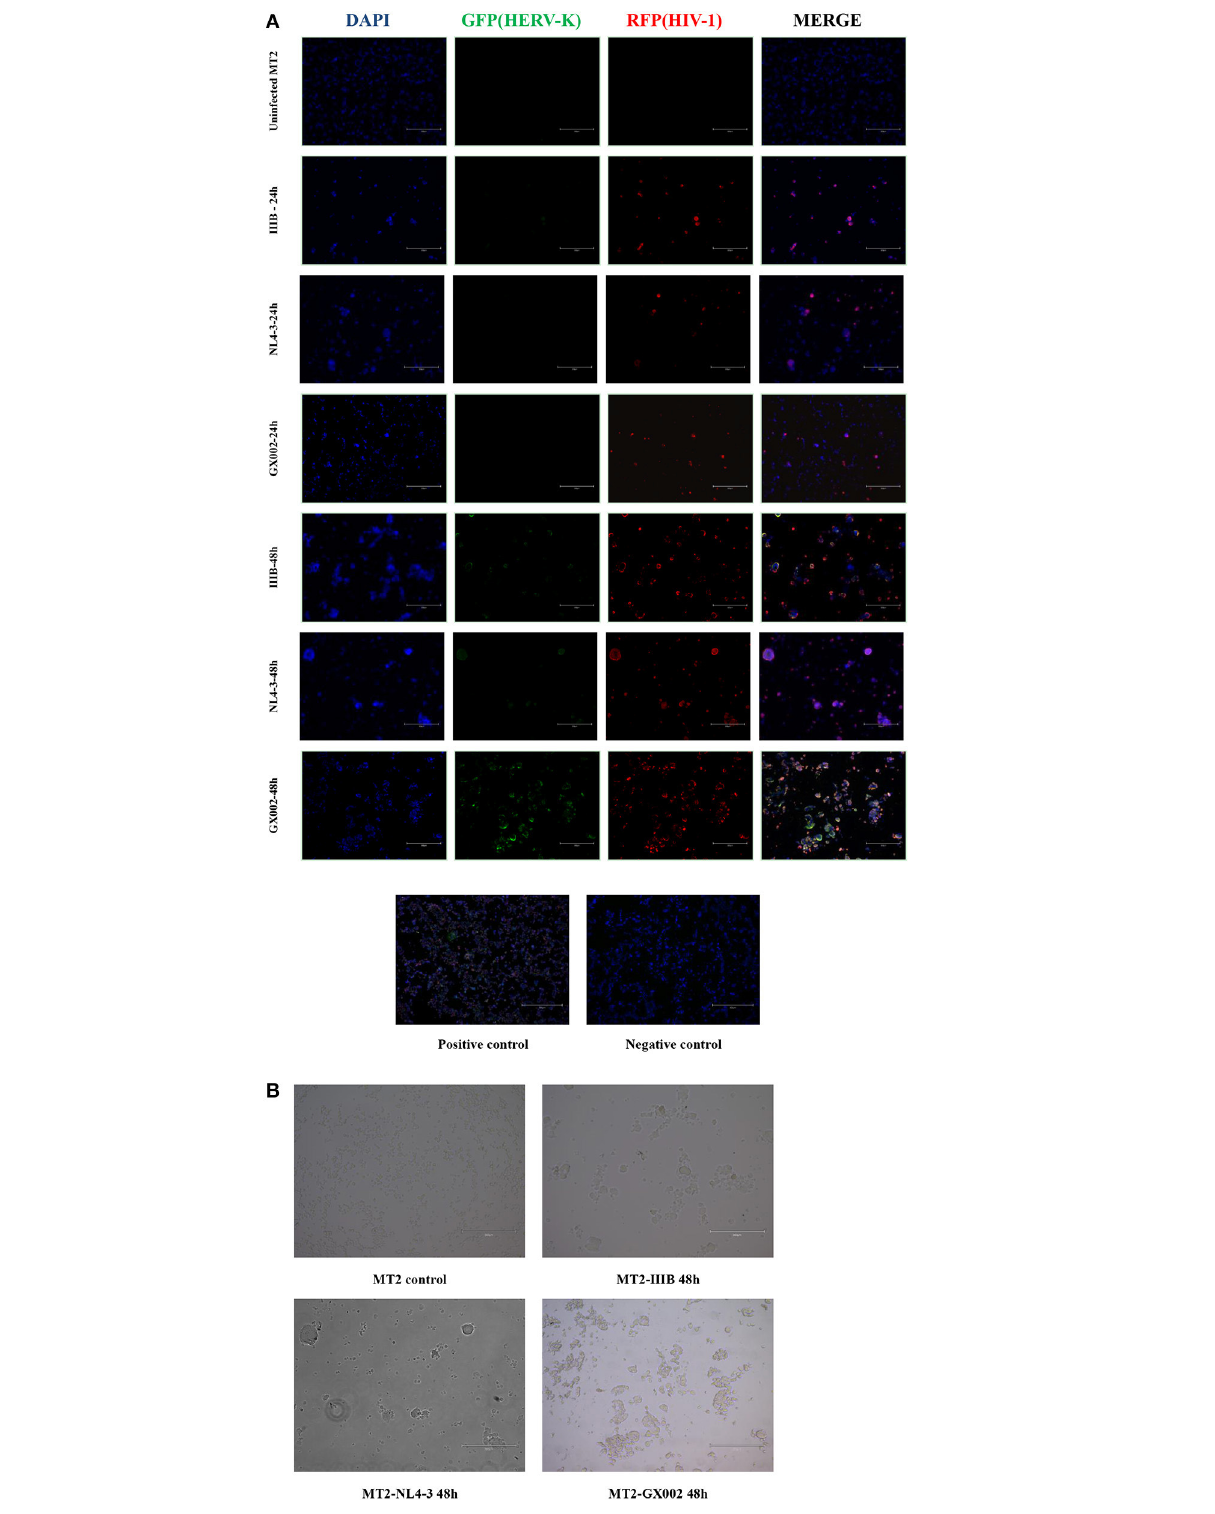
FIGURE 3 | (A) DAPI was used to stain and label the nuclei, green fluorescent proteins (GFP) with a special probe were used to stain and label HEVR-K env region mRNA, and red fluorescent proteins (RFPs) with a special probe were used to stain and label HIV-1 gag-pol region mRNA. The positive and negative controls used standard control probes provided in the kit (ACD). (B) MT2 cells in both the IIIB group and GX002 group exhibited notable cytopathic effects (CPEs) after 48h of infection. The microscopic view of uninfected MT2 cells is shown.